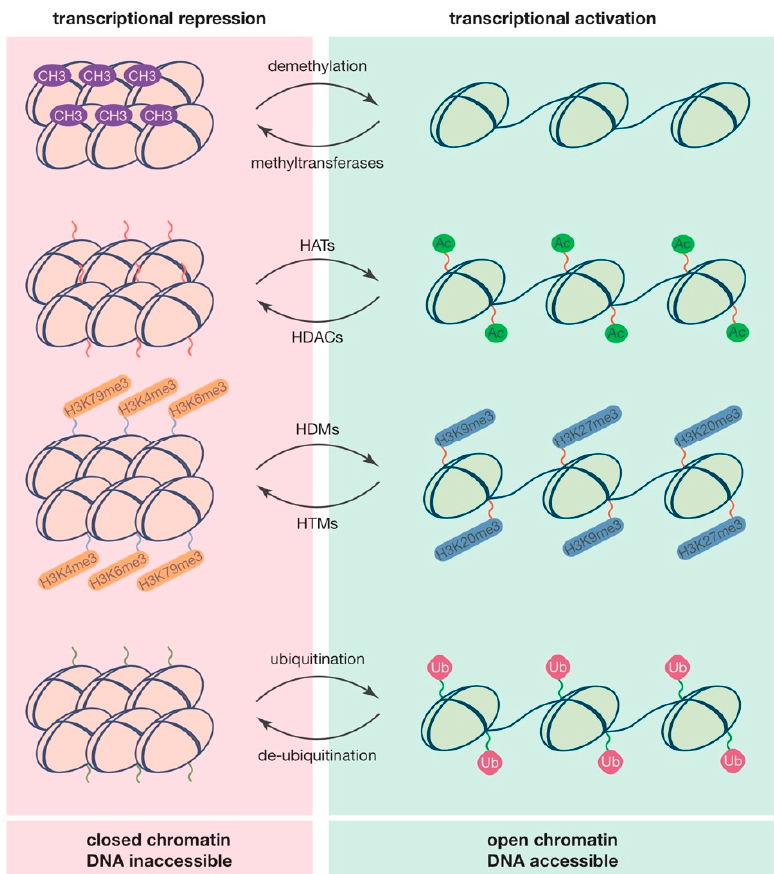
Figure 2. Epigenetic regulation and chromatin remodeling. Chromatin remodeling can be mediated by di ff erent DNA and / or histone modifications such as methylation, acetylation, and ubiquitination. Methylation of DNA is mediated mainly by DNMT3A and DNMT3B in cytosine rich locations. Methylated sites are seen as being transcriptionally inactive. In turn, histones can be either methylated, acetylated, or ubiquitinated. While methylation of DNA is a sign of transcription inhibition, methylation of histones by HMTs can either inhibit or enhance transcription depending on the amount of methylation occurring on the histones. Furthermore, acetylation of histone amino acids is a sign of transcriptional activation. HATs acetylate lysines while HDACs deacylated lysine, influencing transcription by increasing (acetylation) or decreasing (deacetylation) accessibility of genes. Ubiquitination of histones is another process that regulates gene expression. Ubiquitination occurs on both histone 2A lysine 199 and histone 3B lysine 200. The e ff ect of ubiquitination on gene expression is depending on its location, histone 2A lysine 199 has a repressing e ff ect while histone 2B 200 ubiquitination activates gene expression.